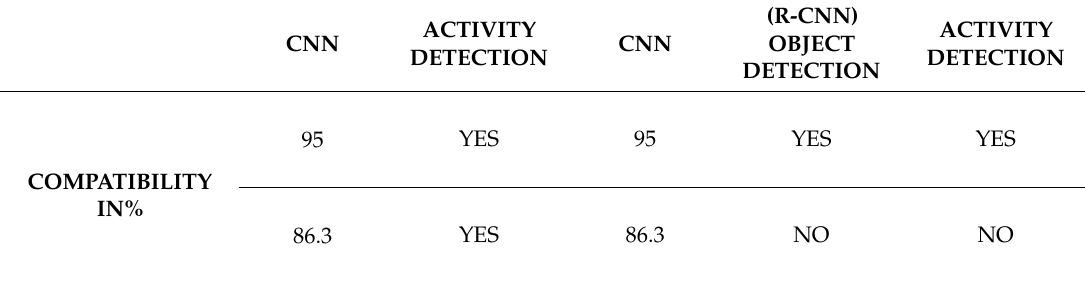
Table 8. Comparison of the e ff ectiveness of using CNN, CNN + R-CNN for identifying the stage of activity in the model for verifying the skills of a new employee in carrying out